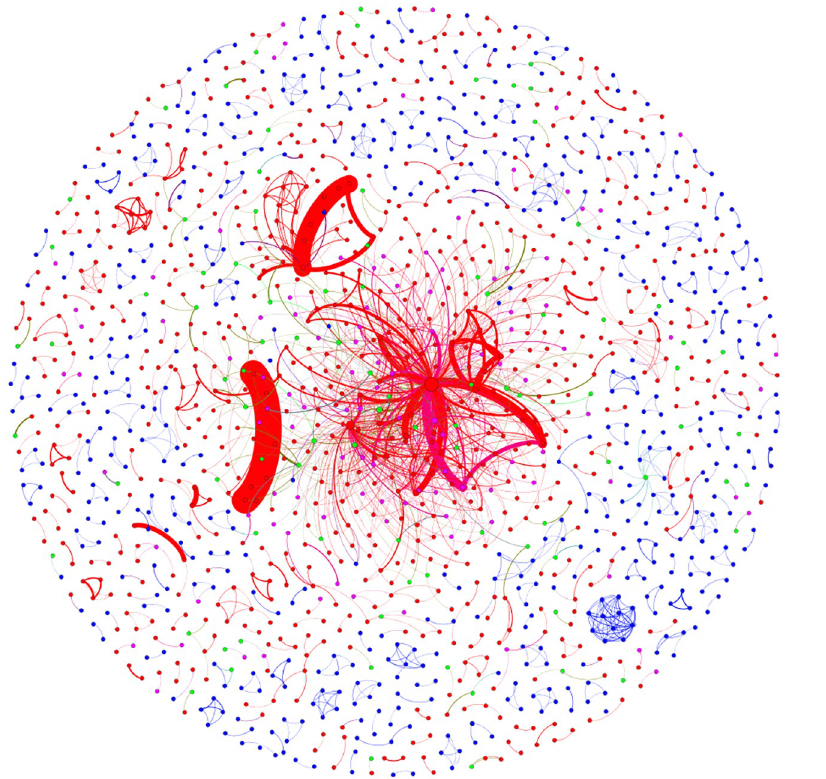
Fig 1. Technical cooperation innovation network map of new energy